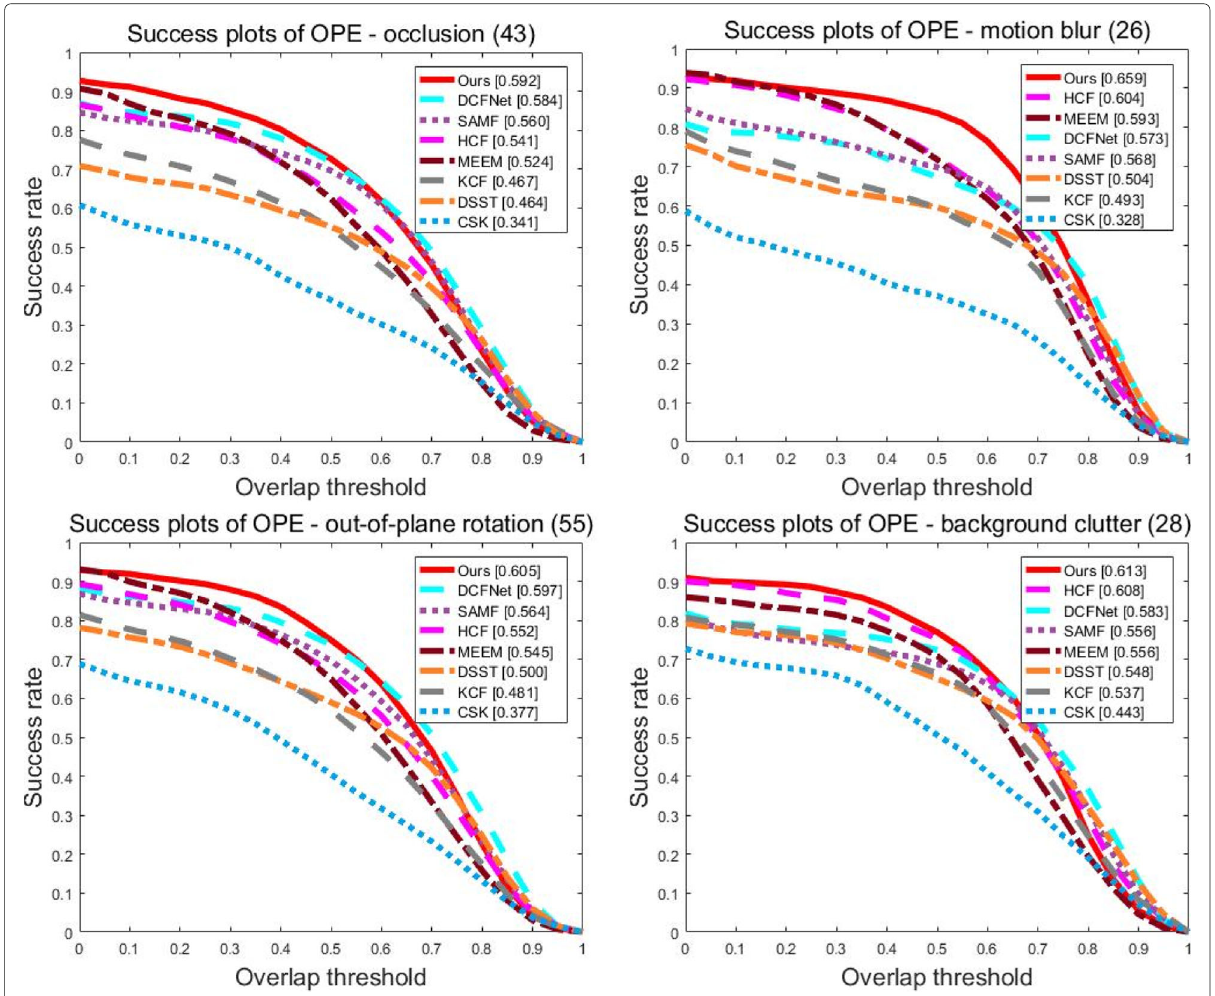
Fig. 7 Overlap success plots in sequence with out-of-plane rotation, occlusion, motion blur, and background